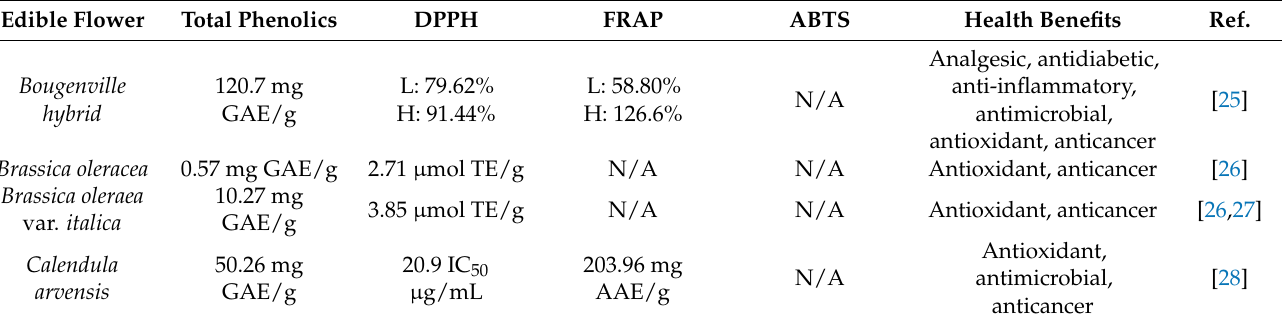
Table 2. Total phenolic content and antioxidant capacity of edible